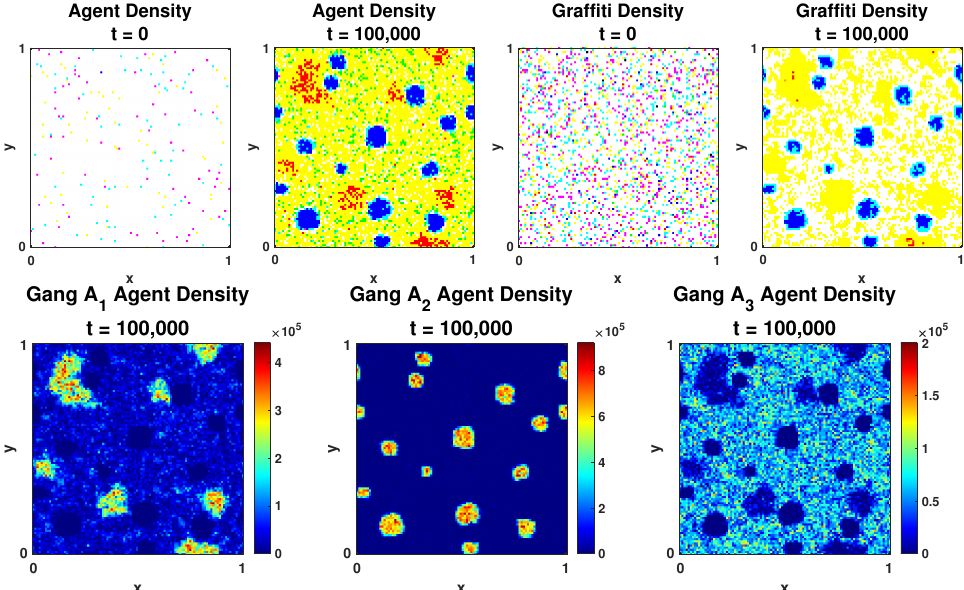
Figure 11. Top row : Agent and graffiti densities’ temporal evolution for the Timidity Model. Here, β 1 = 2 × 10 − 5 , β 2 = 3.5 × 10 − 5 and β 3 = 0.5 × 10 − 5 . We also have N 1 = N 2 = N 3 = 50,000, with λ = γ = 0.5, δ t = 1 and the lattice size is 100 × 100. It is clearly seen that the agents segregate over time. Bottom row : The densities for gangs 1 (left), 2 (middle), and 3 (right) can be seen after 100,000 time